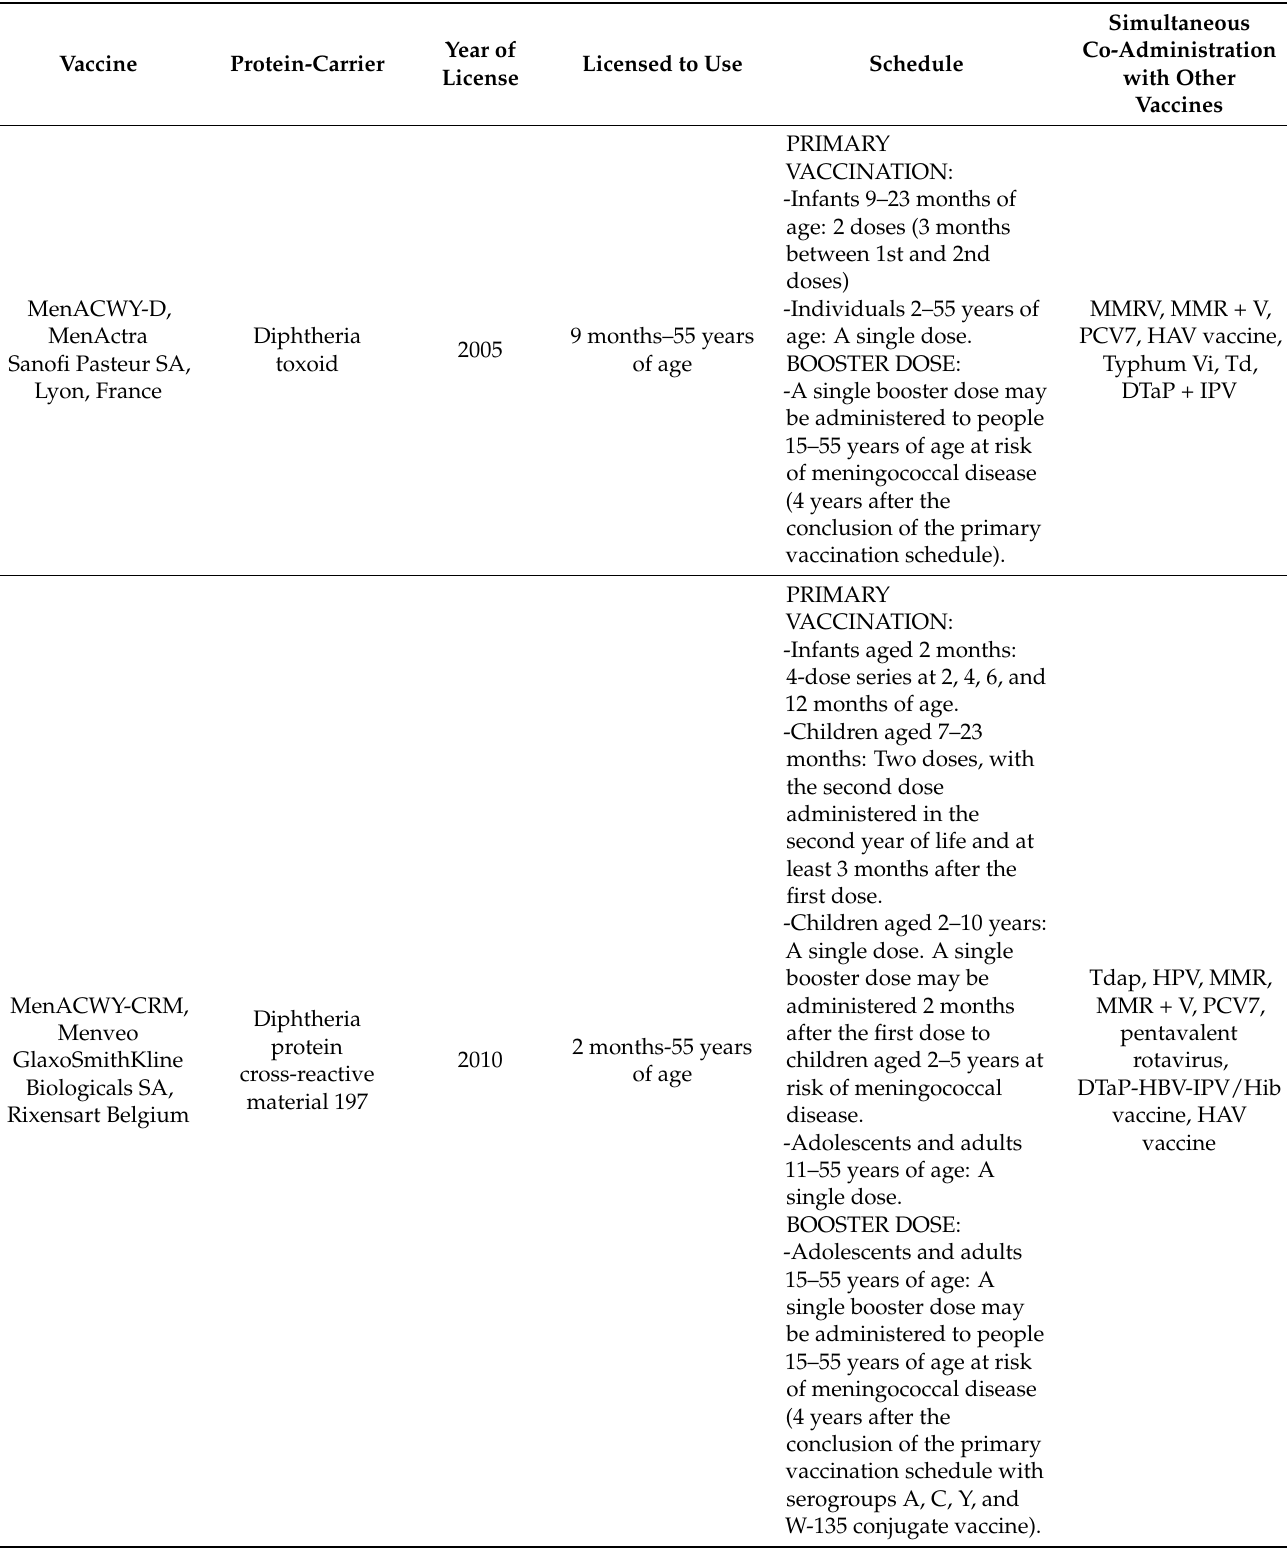
Table 1. Currently licensed and available against serogroups A, C, W, and Y